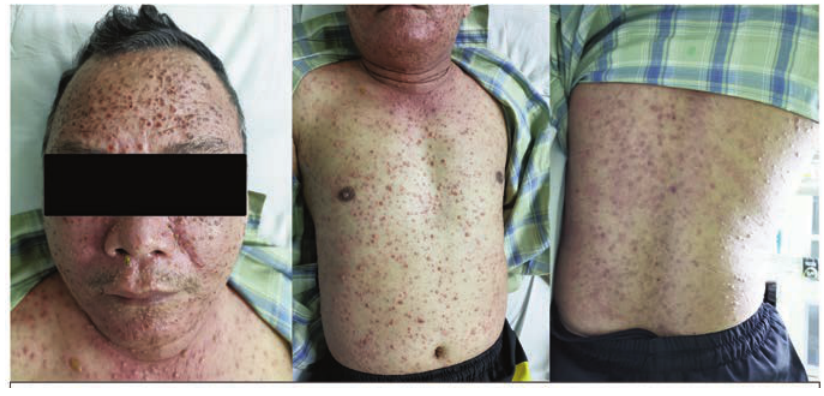
Figure 1. On the facial region, there were multiple pleiomorphic vesicles and multiple crusts. On the trunk, extremities (superior and inferior regions), there were multiple pleiomorphic vesicles. Some of them with umbilication and centripetal distribution.